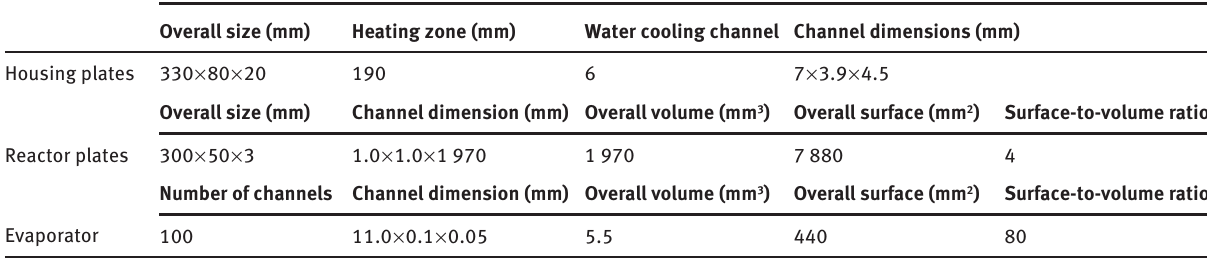
Table 1 Main dimensions of the used reactor system.